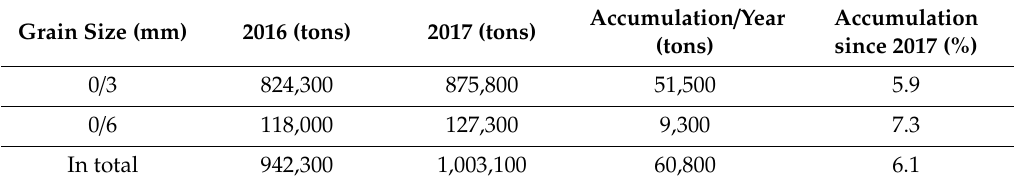
Table 1. The amount of quarry fines at Lemminkäinen Infra Oy